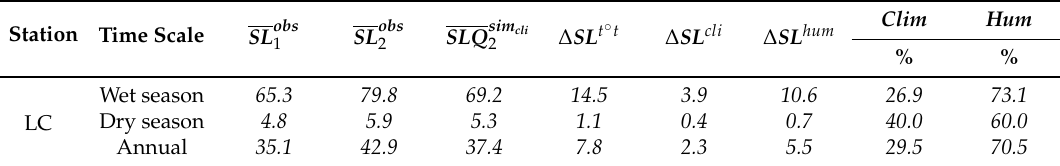
Table 6. Effects of human activities and climate change on the annual sediment load (10 6 ton/year) of Lai Chau station (subscript 1: 1988–1993; subscript 2: 1994–2004). Station Time